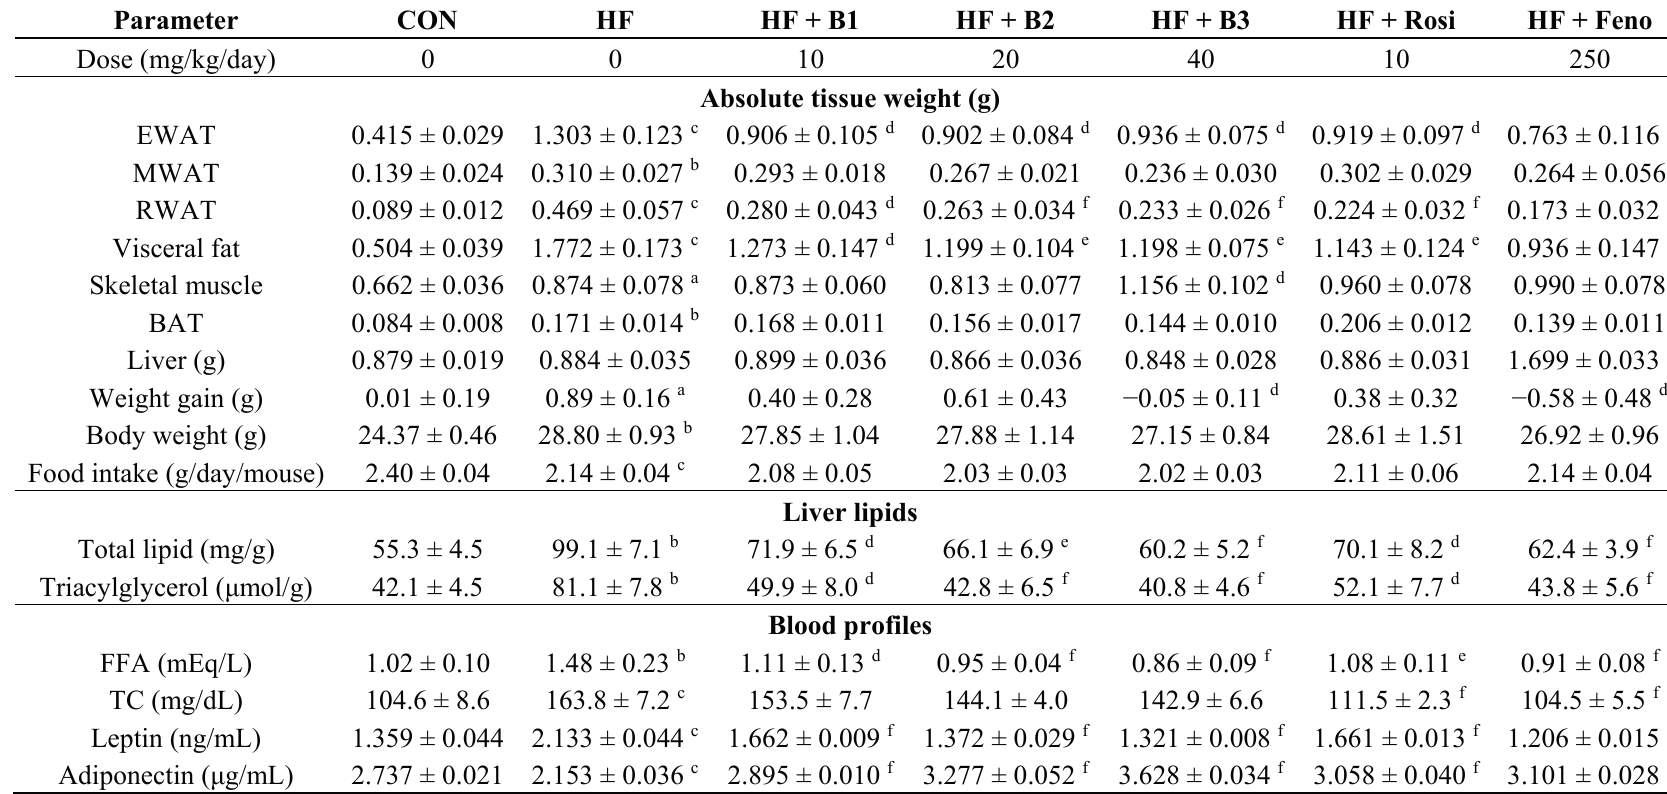
Table 1. Effects of ( − )-epicatechin-3- O - β - D -allopyranoside (BB) on absolute tissue weight, body weight gain, food intake, liver lipid, and blood parameters. All values are means ± SE ( n = 9). a p < 0.05, b p < 0.01, and c p < 0.001 compared with the low-fat diet (CON) group; d p < 0.05, e p < 0.01, and f p < 0.001 compared with the high-fat plus vehicle (distilled water) (HF; high-fat diet control) group. ( − )-epicatechin-3- O - β - D -allopyranoside (BB): B1: 10, B2: 20, B3: 40 mg/kg body wt; Rosi: rosiglitazone (10 mg/kg body wt); Feno: fenofibrate (250 mg/kg body wt). BAT, brown adipose tissue; RWAT, retroperioneal white adipose tissue; MWAT, mesenteric white adipose tissue; FFA, plasm free fatty